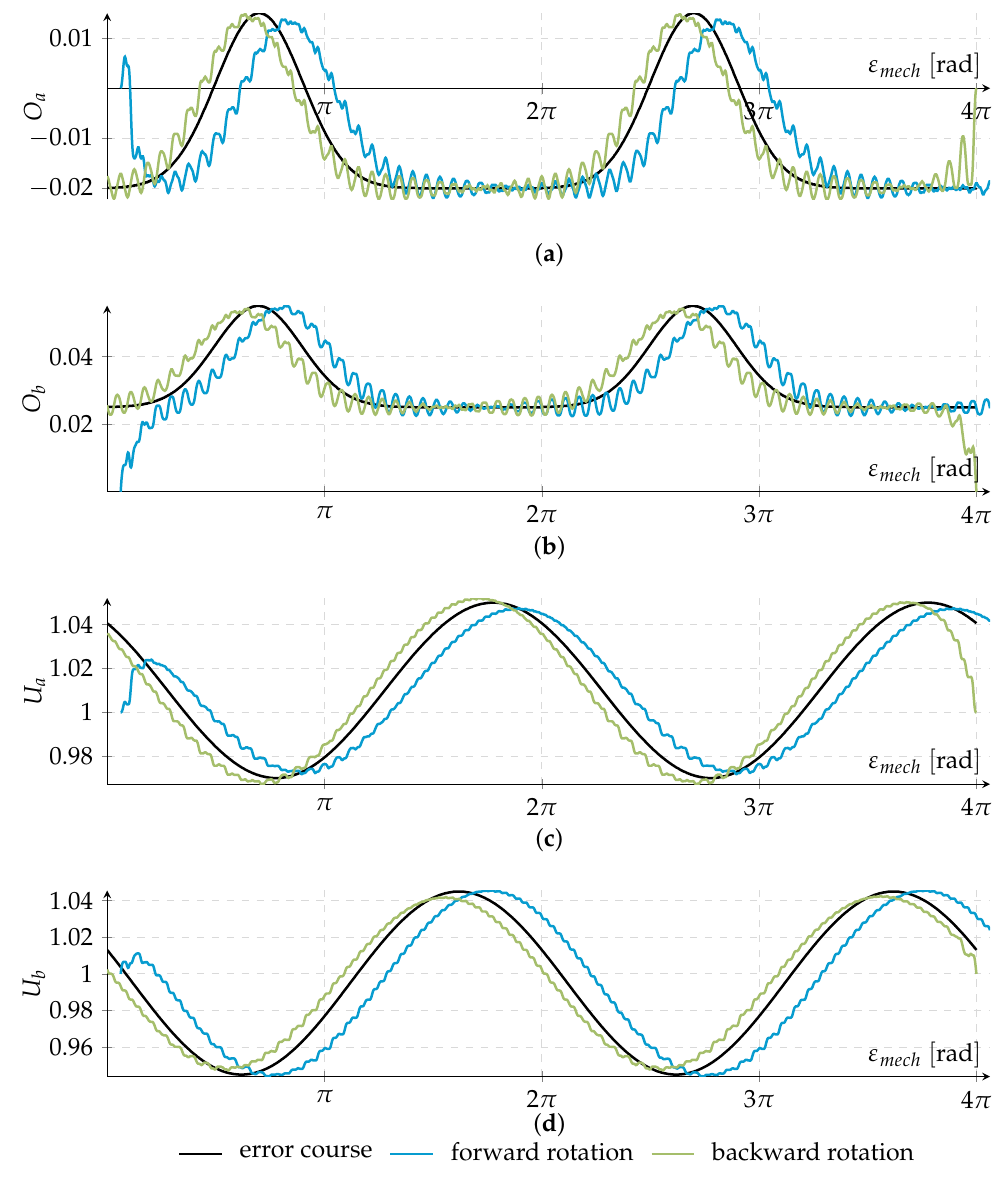
Figure 5. Simulation results for parameter variation over one revolution of ( a ) the offset of line A ; ( b ) offset of line B ; ( c ) amplitude of line A and ( d ) amplitude of line B (32 line cycles per